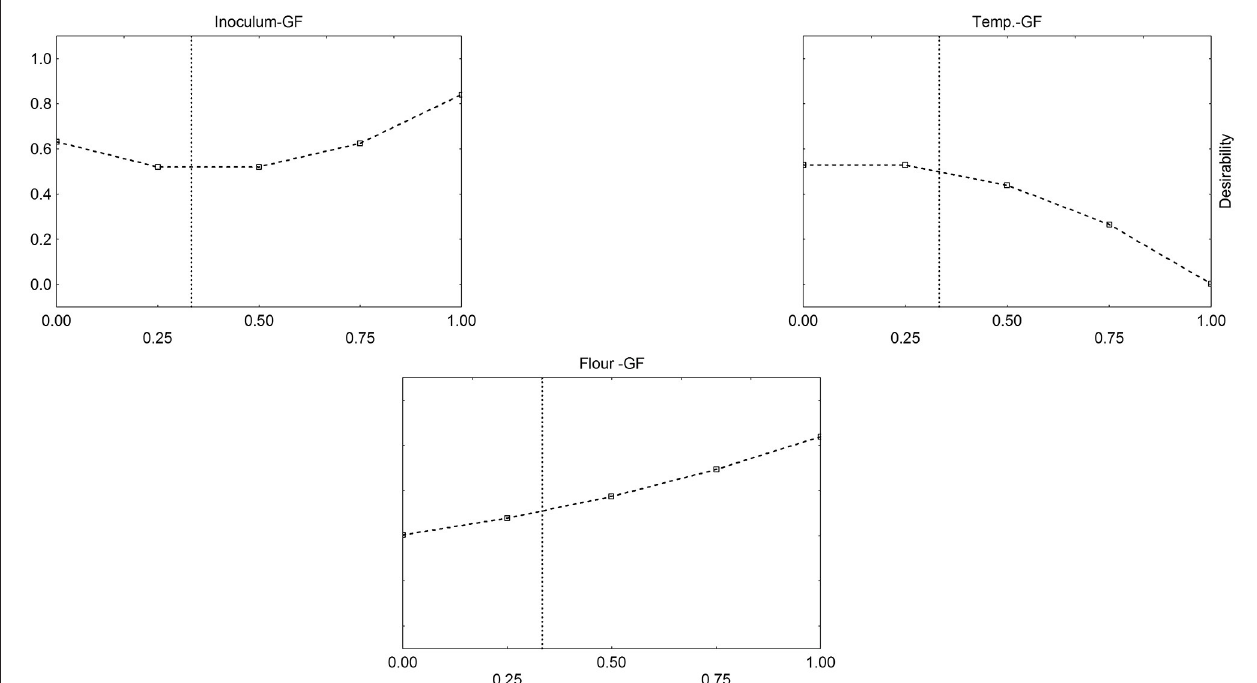
FIGURE 7 | Desirability profiles for the effect of Gluten Friendly Flour (F), inoculum (I), and temperature (T) on the acidification (parameter 1 pH max ) of S. thermophilus .